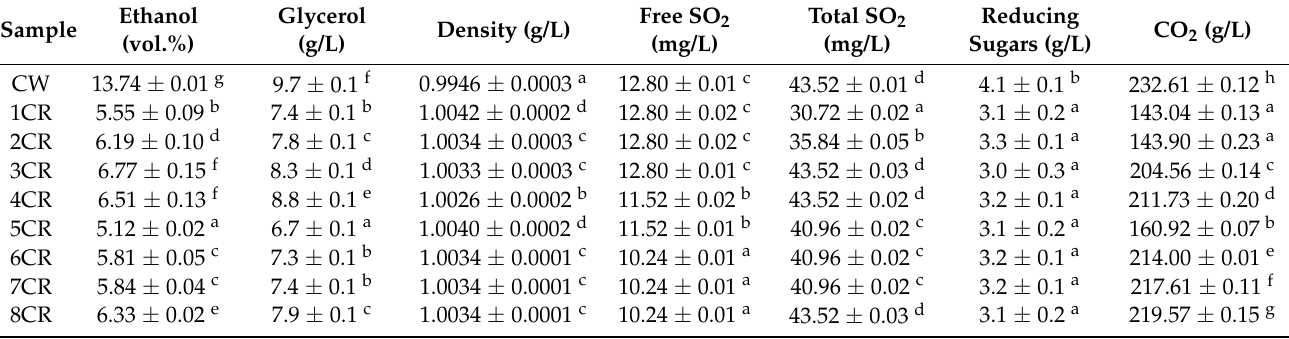
Table 3. Chemical composition of the initial conventional Cabernet Sauvignon wines and the reverse osmosis retentates at 2.5, 3.5, 4.5 and 5.5 MPa, with cooling and without cooling.